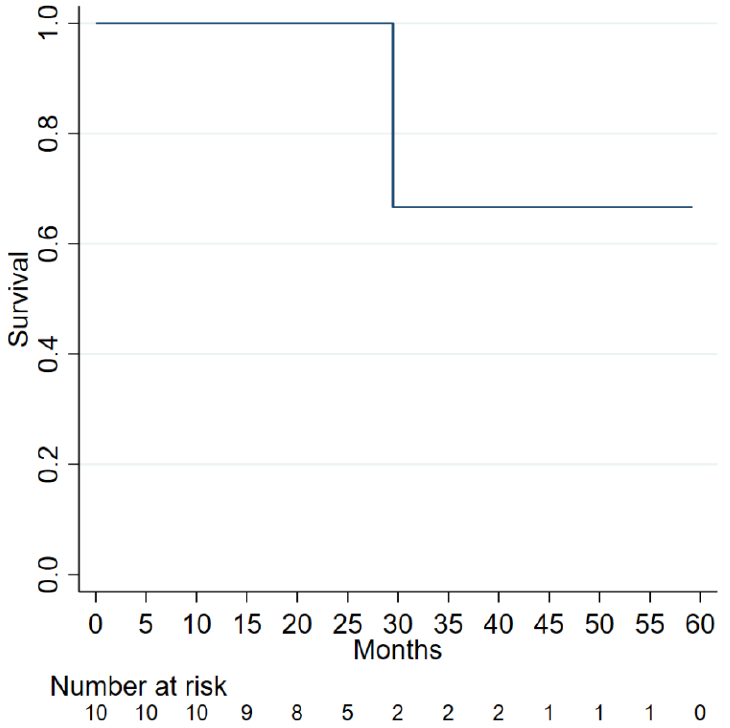
Figure 2. Overall survival was 100% (95% CI 100 – 100) at one year and two years, respectively. In the third year, the overall survival was 75% (95% CI 13 – 96%). One patient died at eight hundred and eighty-five days. This patient died due to acute renal failure superimposed on stage 3 chronic kidney disease.